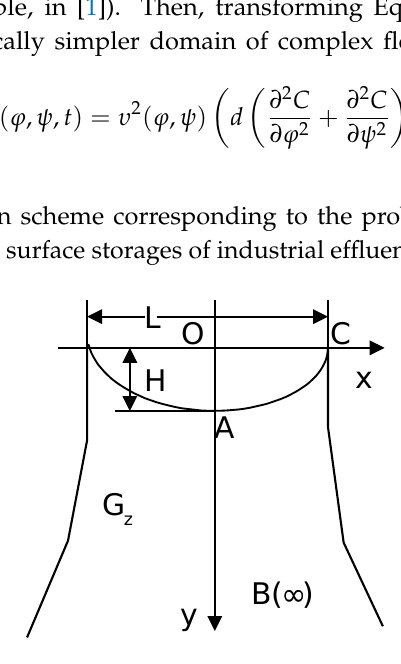
Figure 1. Scheme of filtration in a physical domain.